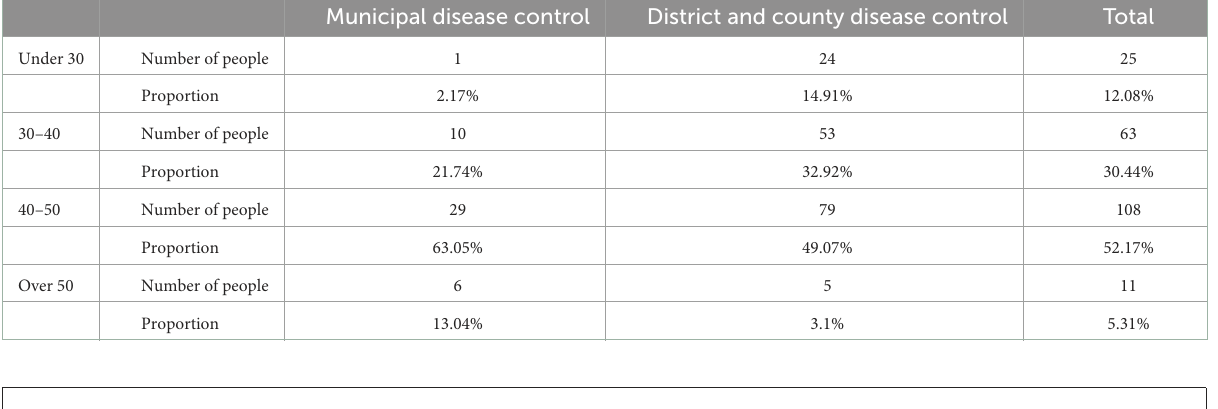
TABLE 1 Age of health emergency personnel in disease control institutions in M